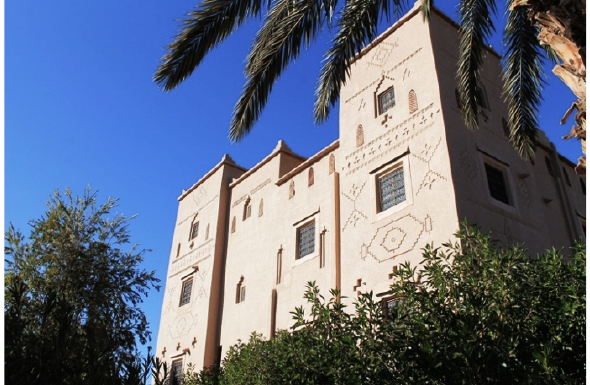
Figure 12. “Kasbah Ait Ben Damiette”, Ouled